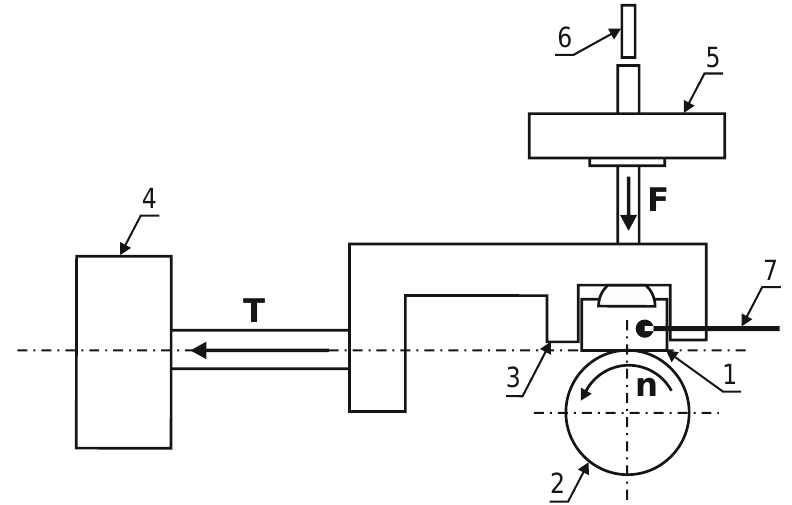
Figure 6. The diagram of a T-05 tester: (1) nitrided layer, (2) roll, (3) sample holder, (4) sensor for measuring the friction force, (5) load, (6) displacement sensor, (7) thermocouple.